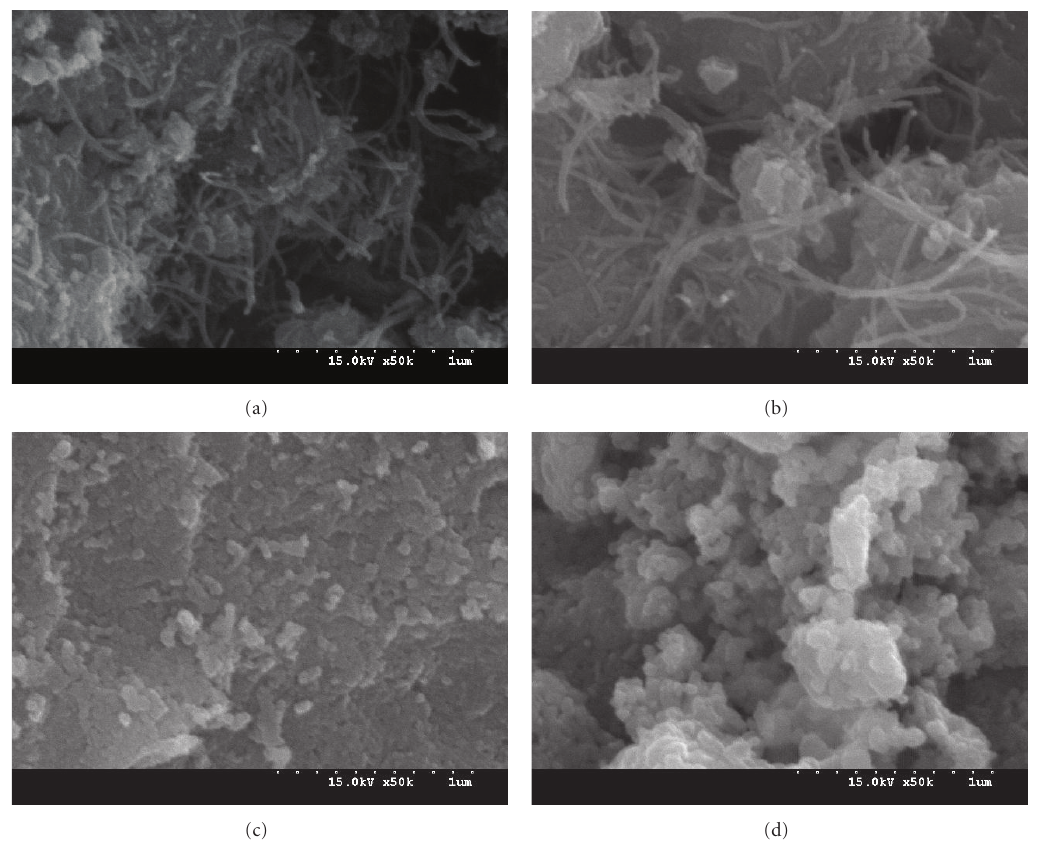
Figure 4: Scanning electron microscopy images of MWNT-TiO 2 at four di ff erent calcination temperatures (300, 400, 500, and 600 ◦ C).